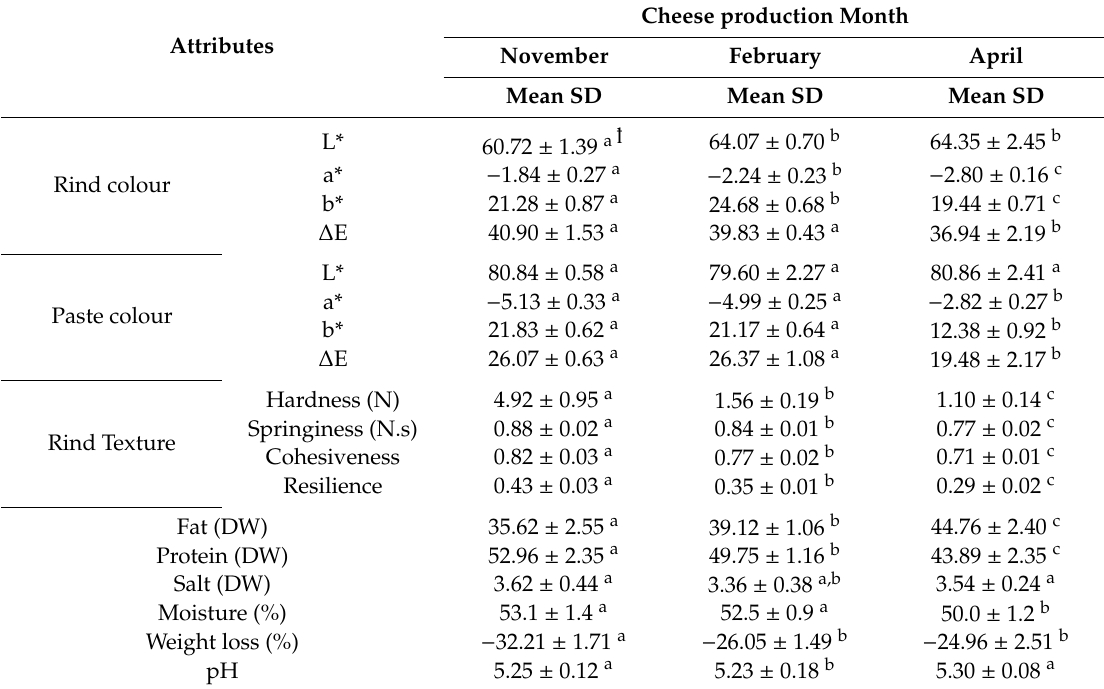
Table 4. The influence of flock lactation stage (November, February and April) in the physicochemical attributes of cheeses, accessed by analysis of variance. SD-standard deviation